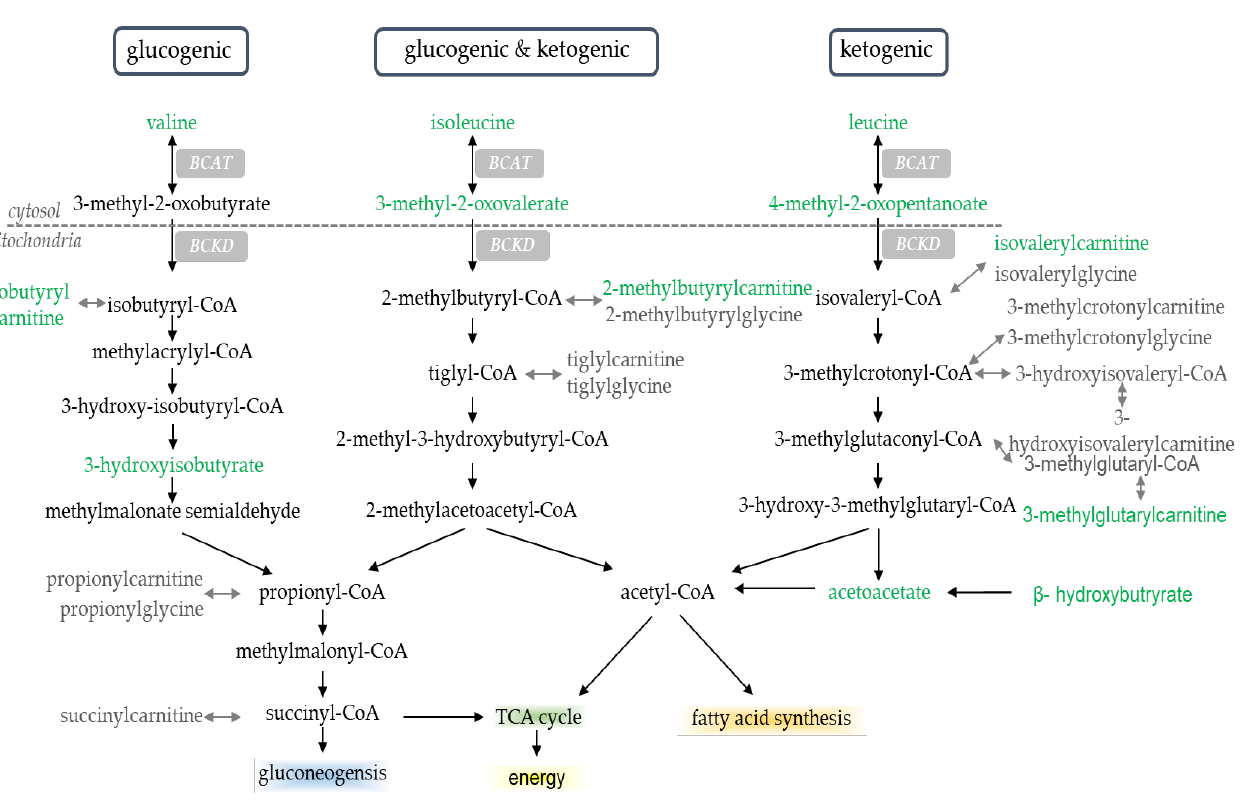
Figure 5. Branched-chain amino acid metabolites. Metabolites highlighted in green were significantly different in LOW compared to AD; p < 0.05, Q < 0.10. Endpoint of metabolism (e.g., TCA cycle, fatty acid synthesis, energy, and gluconeogenesis) highlighted for effect.